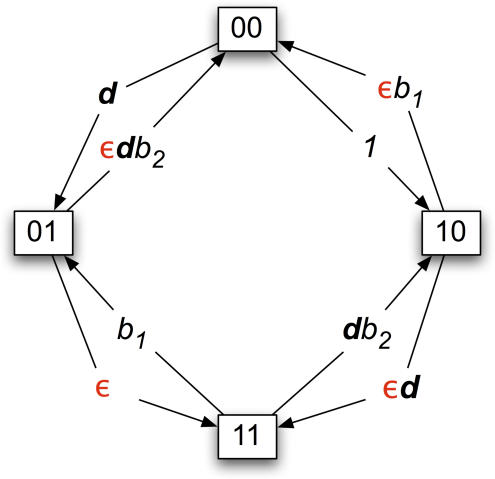
Disequon Model ParametersThis diagram illustrates the eight rates that are parameterized by the disequon (paired-character) model. Each box corresponds to a state in the disequon model, in which the first digit represents the presence or absence of a PNGS at the first site, and the second digit for the second site. The interaction parameter (ɛ) between paired sites is highlighted in red.